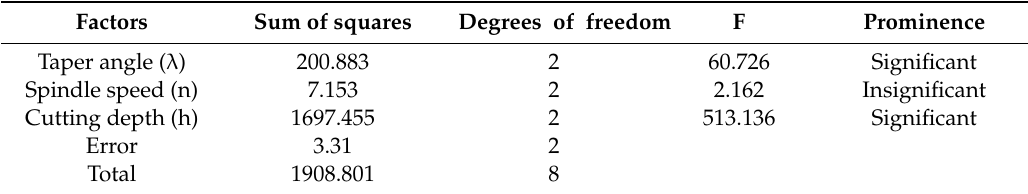
Table 5. ANOVA results of resultant force (F R ).